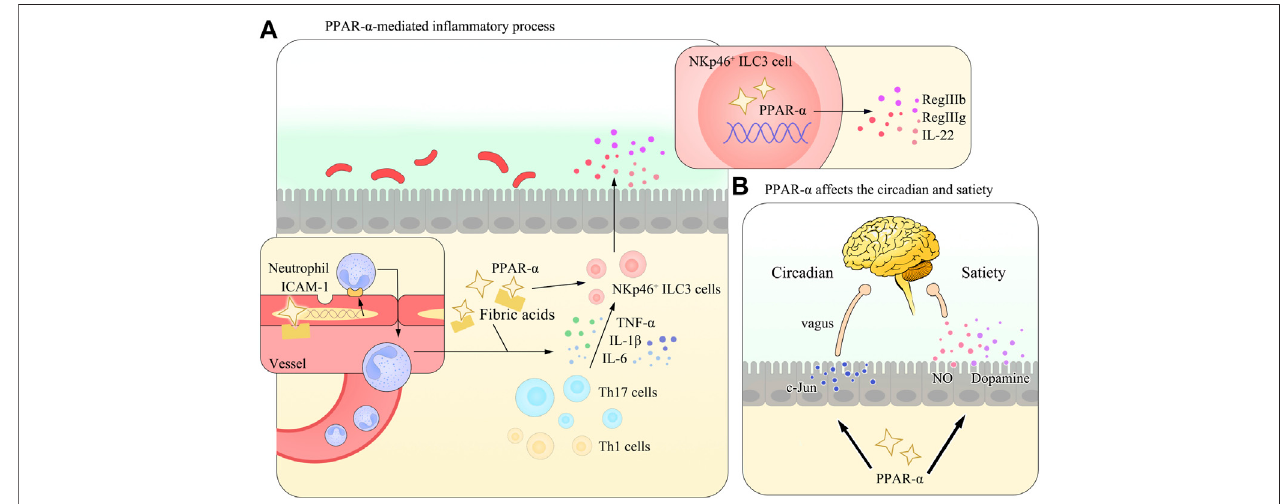
FIGURE 2 | Diagram of the PPAR- α – mediated in fl ammatory process and the regulation of circadian rhythms or circadian clock and satiety in the gut. (A) In many gastrointestinal diseases, PPAR- α isactivated and initiates the expression ofmultiple anti-in fl ammation mediators, including ICAM-1 in vascular epithelial cells and IL-22 in NKp46 + ILC3 cells. These effects help reverse the imbalance of the T-cell number and maintain the homeostasis of the GIT. (B) Apart from its role in regulating the in fl ammatory process, PPAR- α could also affect the circadian rhythms or circadian clock ( via the regulation of the c-Jun expression) and satiety (by controlling the secretionofNO,asmentionedinthemainbodyofthereview,and Figure3 and Table3 arereferred fordetailedinformation)inthebody.Studieshavedemonstratedits close relation with NO and dopamine, while the detailed mechanism remains to be elucidated.